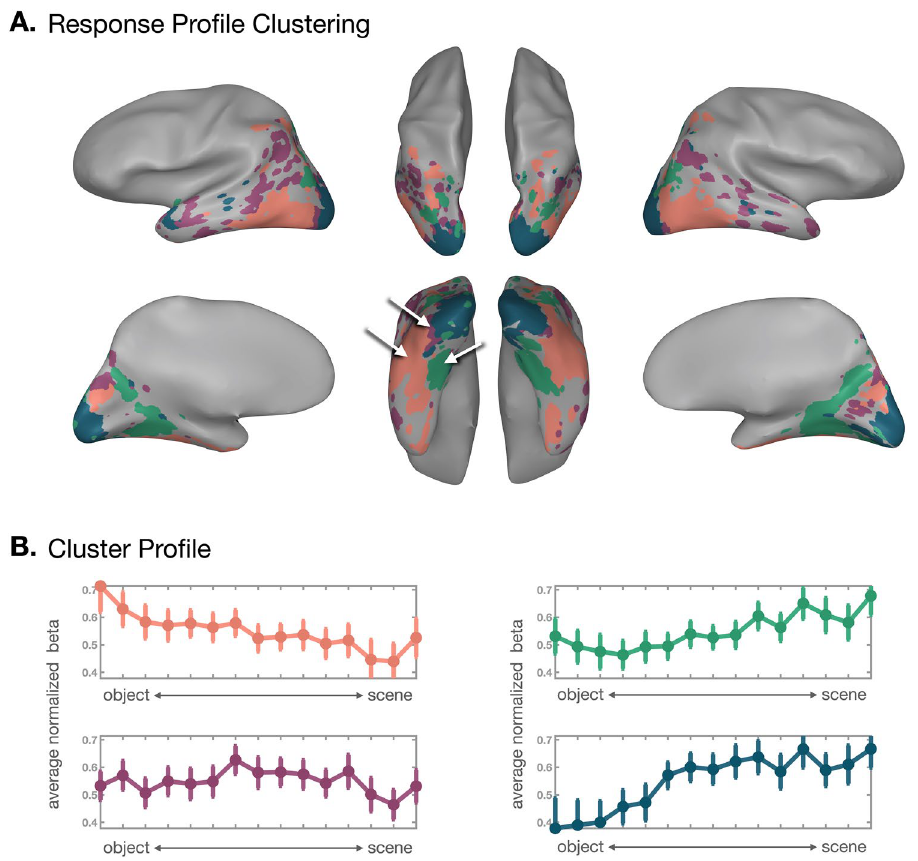
Figure 3. Response Profile Clustering. ( A ) The RPC results are visualized on an example subject brain ( k = 4). Each voxel is colored based on its assigned cluster, and clusters with more similar response profiles have colors that are more similar in hue. The white arrows point to the three major clusters, and they are positioned in identical locations to Fig. 2 with respect to the brain. ( B ) The response profile of each cluster is plotted with the corresponding cluster color on the brain plot. The betas from each cluster are normalized to the grand mean and averaged across the voxels. The error bar represents +-1 standard deviation. The pink cluster shows the highest activation to single-object views and gradually less response toward the far-scene views. The green cluster shows the opposite pattern, where the highest activation was at the far-scene views. The purple cluster activation peaks for intermediate-scale views. The dark green cluster seems to have a similar response pattern to the green cluster, but it closely corresponds to independently defined early visual